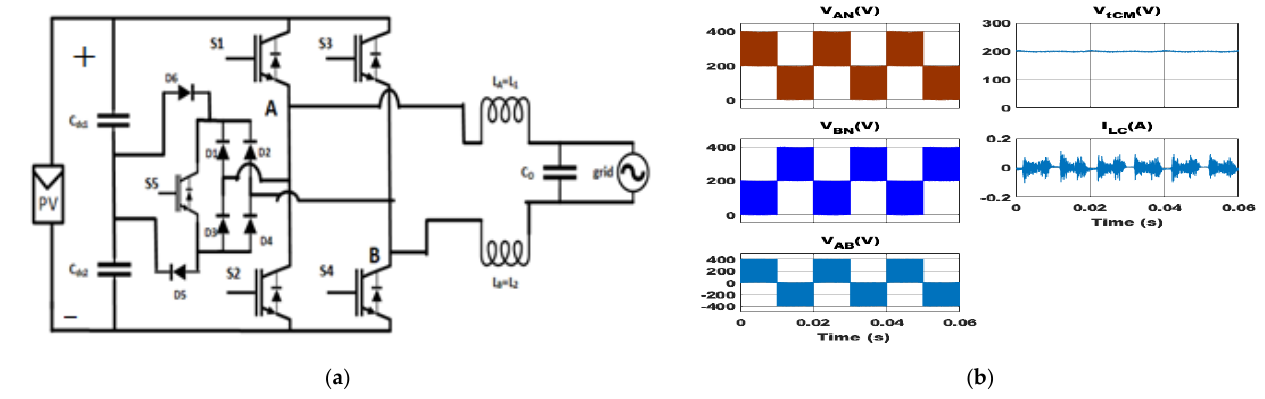
Figure 18. HBZVR-D topology: ( a ) circuit structure; ( b ) simulation results.